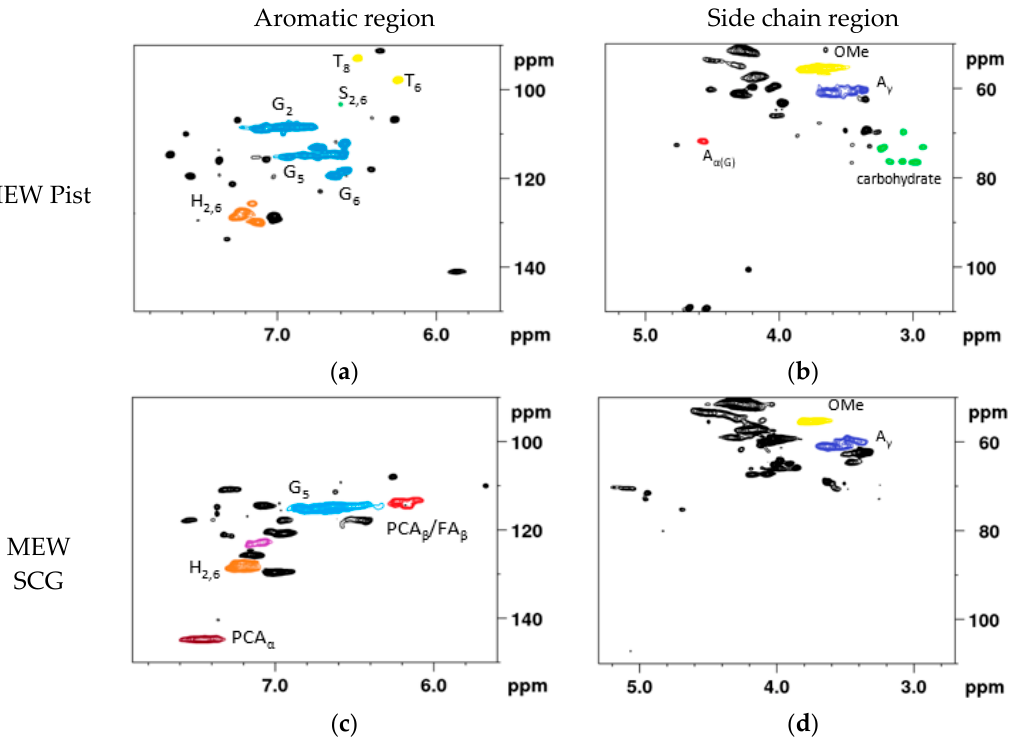
Figure 4. Two-Dimensional Nuclear Magnetic Resonance (2D-NMR) analysis of LEF obtained using MEW. See Table 5 for label assignments.